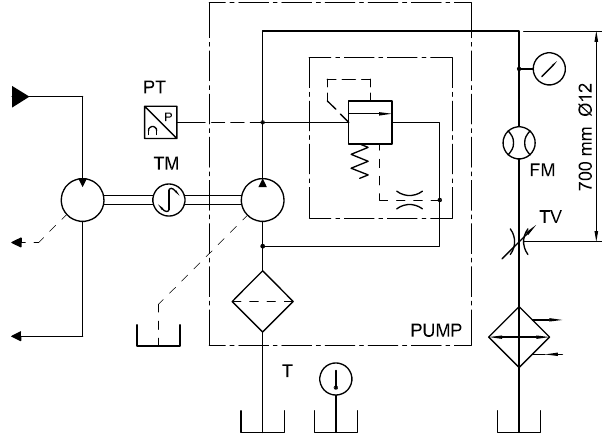
Figure 15. Hydraulic scheme of the test rig.